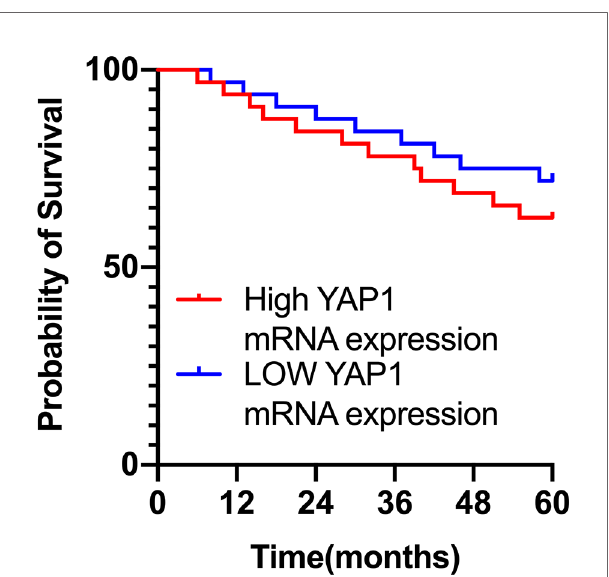
FIGURE 1 | Survival curve of CMM patients in YAP1 mRNA high and low expression groups. been found to have the most signi fi cant effect (p <0.05) ( Figure 3 ). Spearman test results indicated that YAP1 expression in Ribo-seq was negatively correlated with the weight of CMM mice after treatment (r = -0.735, p <0.05), while YAP1 expression in RNA-seq and RT-qPCR was irrelevant to tumor tissue weight (r=-0.347, p >0.05; r = -0.299, p >0.05). However, as another important gene member on the Hippo signaling pathway, TAZ, we did not fi nd obvious changes in its expression by UMMD treatment in the results of Ribo-seq (P > 0.05), as did RT qPCR with RNA SEQ (P > 0.05) ( Figure 4 ).